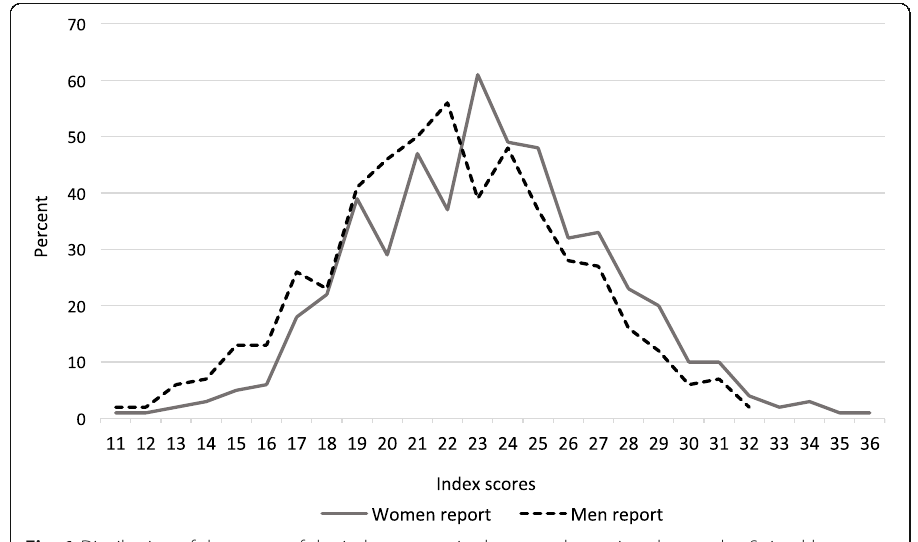
Fig. 1 Distribution of the scores of the indexes on attitudes towards marriage by gender. Striped bars represent statistically non-significant